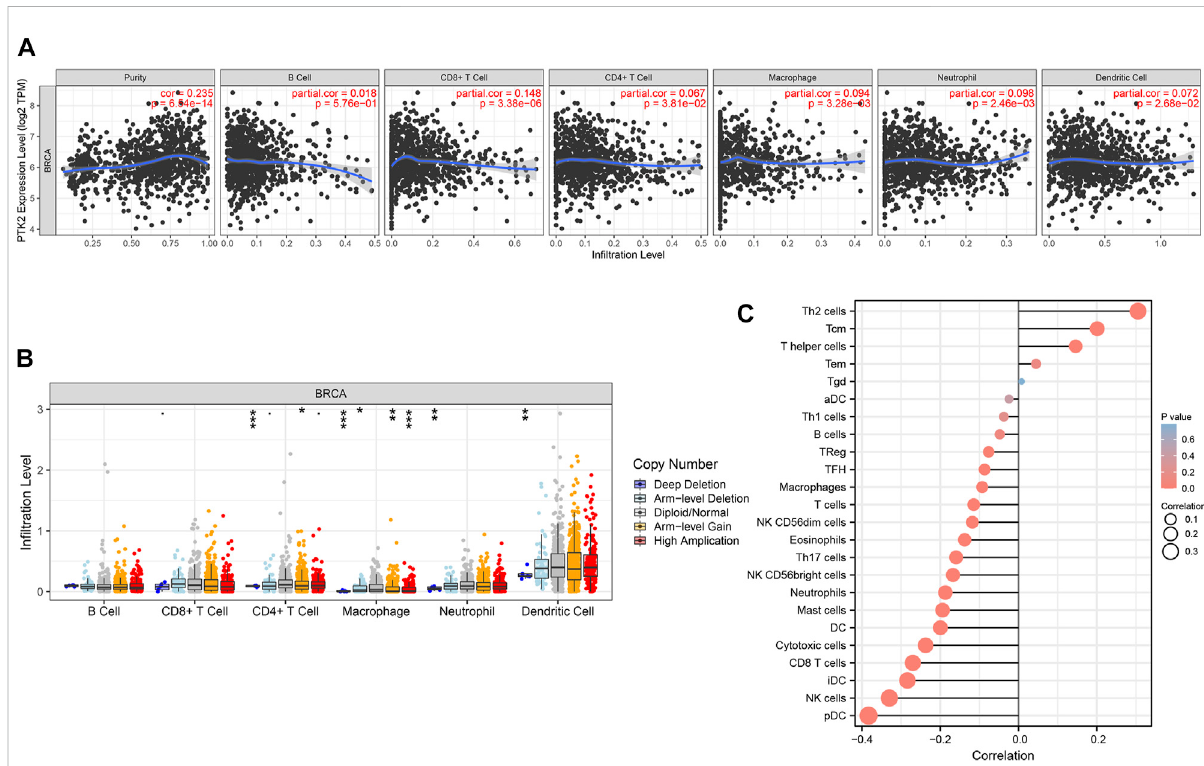
FIGURE 6 Correlations of PTK2 expression with immune in fi ltration level in breast cancer. (A) PTK2 is signi fi cantly associated with tumor purity and is correlated with the in fi ltration of different immune cells using the TIMER database. (B) PTK2 CNV affects the in fi ltrating levels of CD4 + T cells, macrophages, neutrophils, and dendritic cells in breast cancer. (C) PTK2 expression has a signi fi cant correlation with the in fi ltration of immune cells in breast cancer using the ssGSEA analyses. * p < 0.05; ** p < 0.01; *** p <